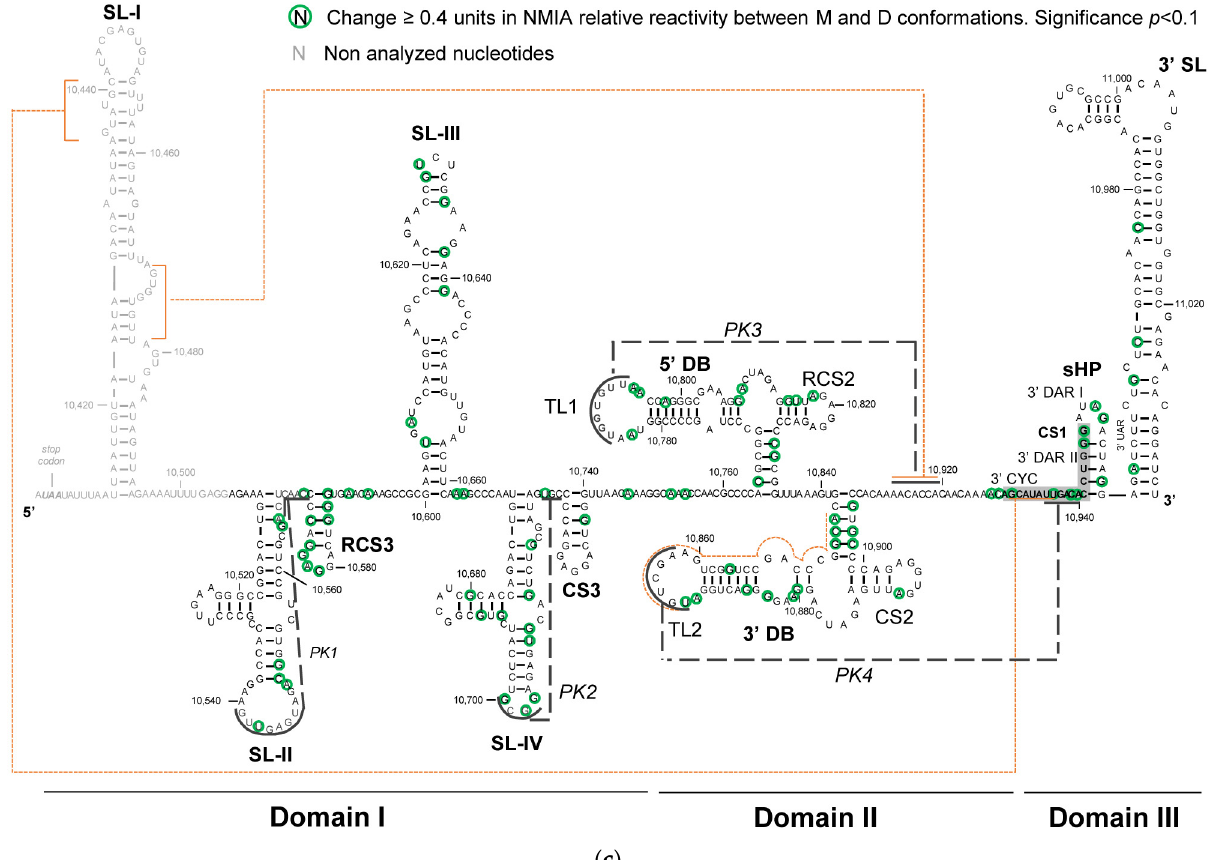
Figure 3. Identification of the structural determinants for dimer formation in the 3 ′ UTR of WNV. Structural requirements at single nucleotide positions were detected by 2 ′ -hydroxyl molecular interference (HMX). ( a ) The graph shows the NMIA reactivity profile under denaturing conditions for each of the isolated conformers of the 3 ′ WNV molecule. The monomeric and dimeric forms were partitioned by native agarose gel electrophoresis. Modified positions were identified as stops by reverse transcription. Data are the mean of four independent experiments ± standard deviation. M, monomer, solid black line; D, dimer, solid red line. ( b ) Differential NMIA reactivity profile for the dimer vs. monomer forms. HMX scores indicated at precise positions were calculated from the reactivity profiles of the monomeric and dimeric conformers, as previously described [22]. ( c ) Sequence and secondary structure of 3 ′ WNV RNA indicating the main HMX results. Green circles indicate a significant ( p < 0.1) increase or decrease of ≥ 0.4 NMIA reactivity units. Reactivity data were used to predict a theoretical structural model, including intra- and/or intermolecular interactions (depicted as orange dashed lines), with the software RNAStructure. The CS1 sequence is shadowed.